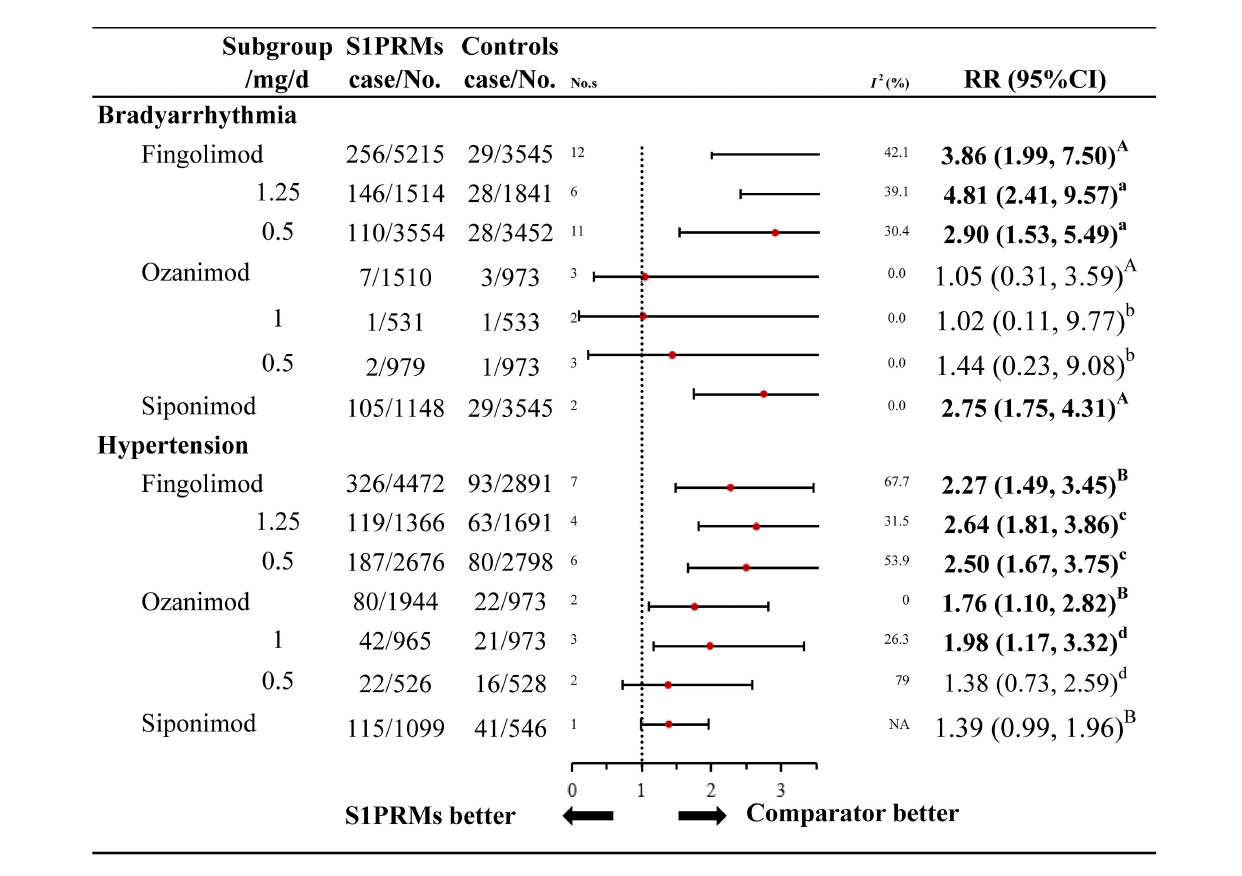
FIGURE 3 | Subgroup analysis of high-risk cardiovascular adverse events of different S1PRMs. A , for individual S1PRMs in bradyarrhythmia, P interaction = 0.140; B , for individual S1PRMs in hypertension, for P interaction = 0.266; a , for different doses of fi ngolimod in bradyarrhythmia, P interaction = 0.360; b , for different doses of ozanimod in bradyarrhythmia, P interaction = 0.851; c , for different doses of fi ngolimod in hypertension, P interaction = 0.900; d , for different doses of ozanimod in hypertension, P interaction = 0.408; NA, not applicable; I 2 , heterogeneity; No. s, numbers of studies; RR, relative risk; 95% CI, 95% con fi dence interval; S1PRMs, sphingosine-1-phosphate receptor modulators; DMTs, disease modulating